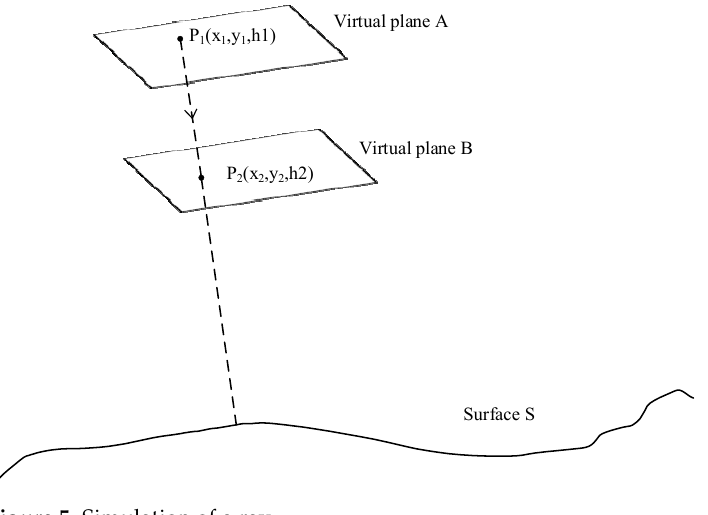
Figure 5. Simulation of a ray.